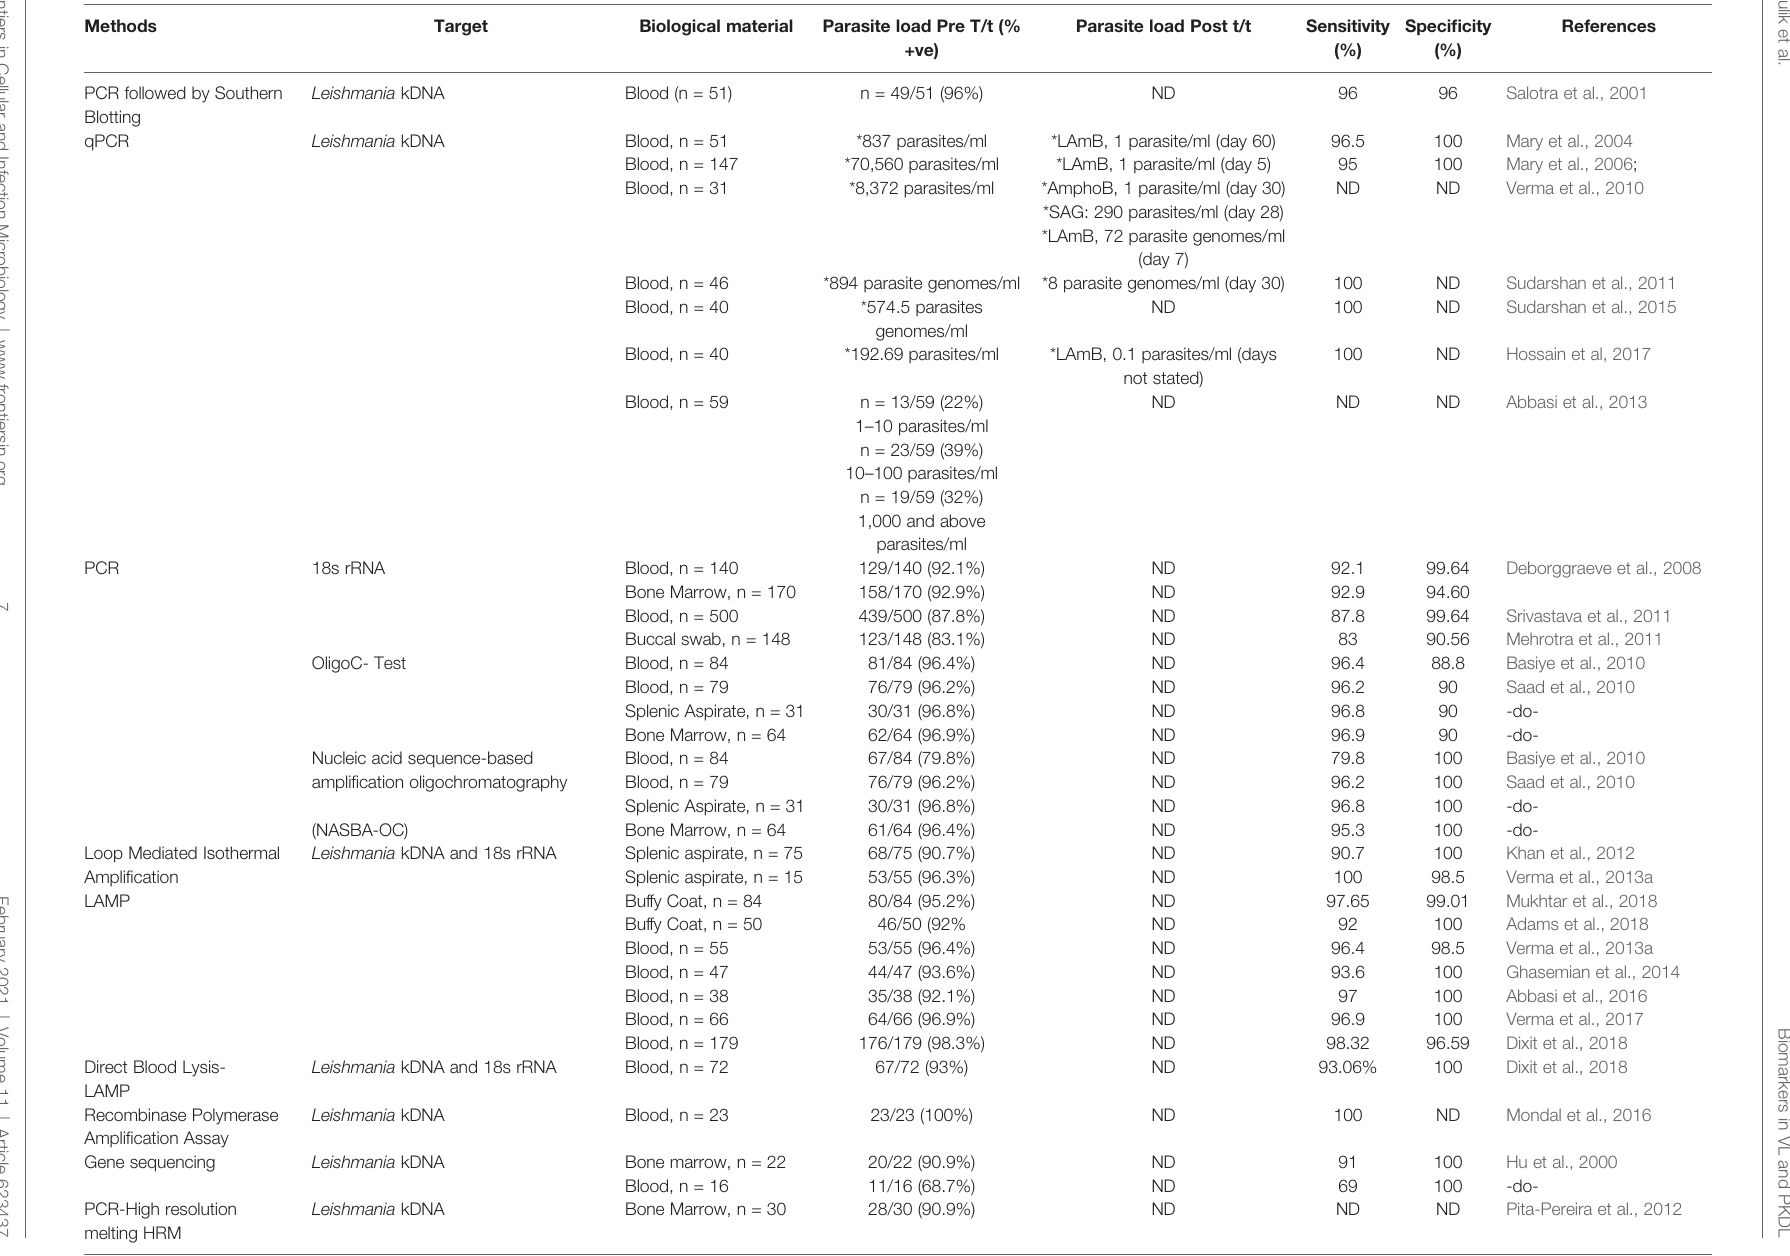
TABLE 2 | Nucleic Acid Markers of